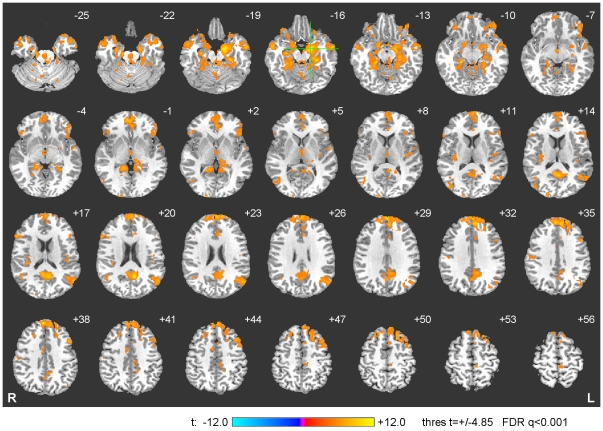
Functional Connectivity Analysis for the Amygdala Network.The group functional connectivity analysis using a seed ROI in the left amygdala region revealed a fronto-temporo-limbic network (see text for details and Table 3 for coordinates). The connectivity maps are projected on a representative single-subject T1 template in the Talairach space. The coordinates and orientation of each slice are described in the legend for Figure 7. The green crosshairs mark the center of the seed ROI for the connectivity analysis.